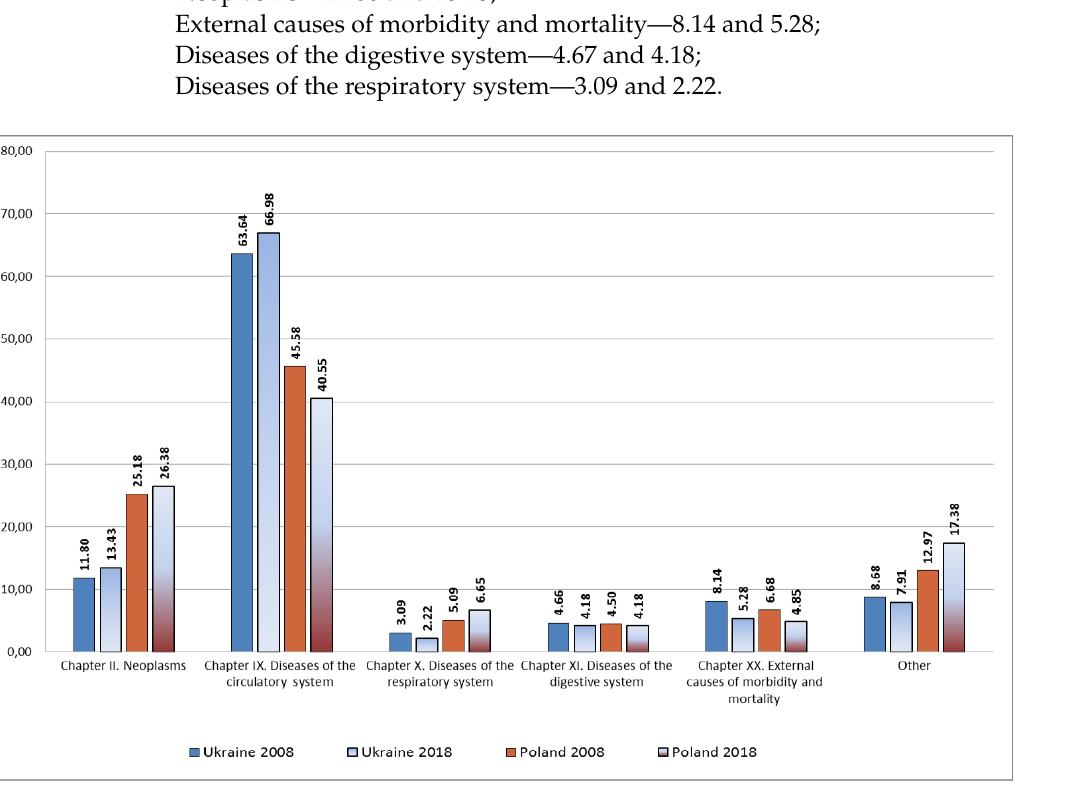
Figure 1. The main causes of mortality in Ukraine and Poland in 2008 and 2018 (in %).